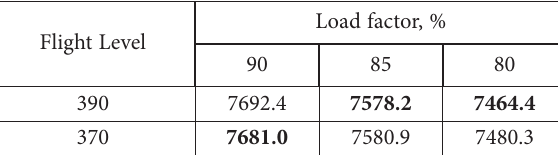
Table 7. Trip fuel in kg, 2500 km flight, ‘New’